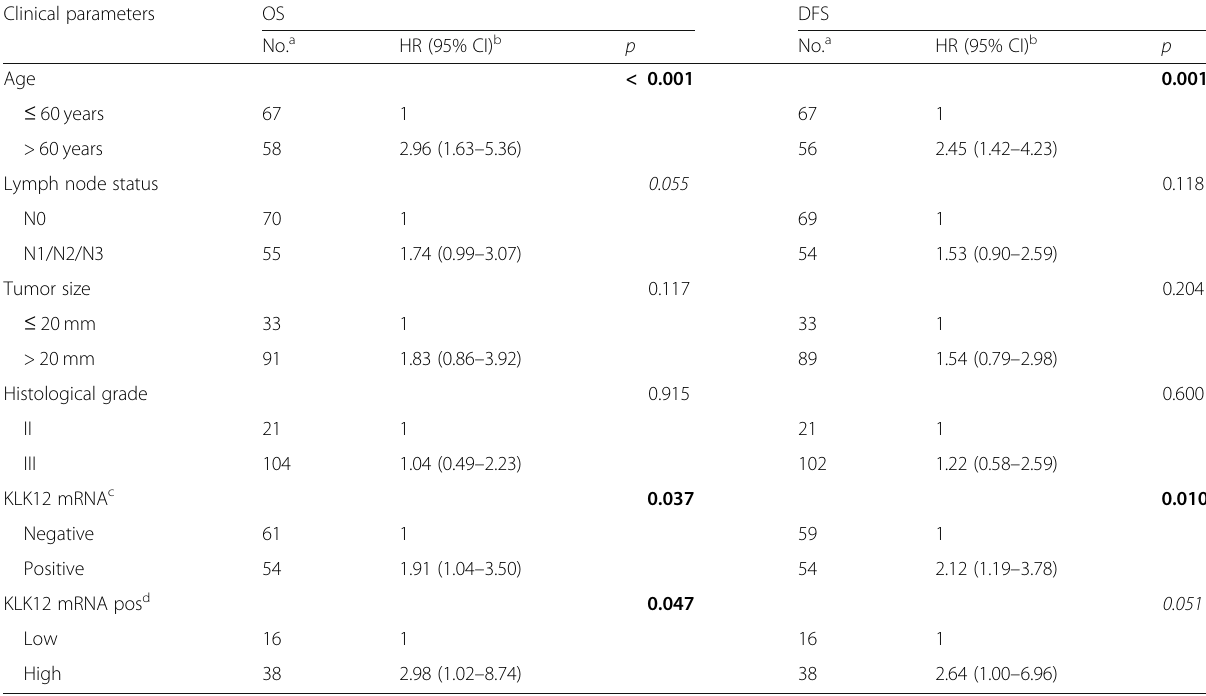
Table 2 Univariate Cox regression analysis of KLK12 mRNA expression in relation to patients ’ outcome in triple-negative breast cancer Clinical